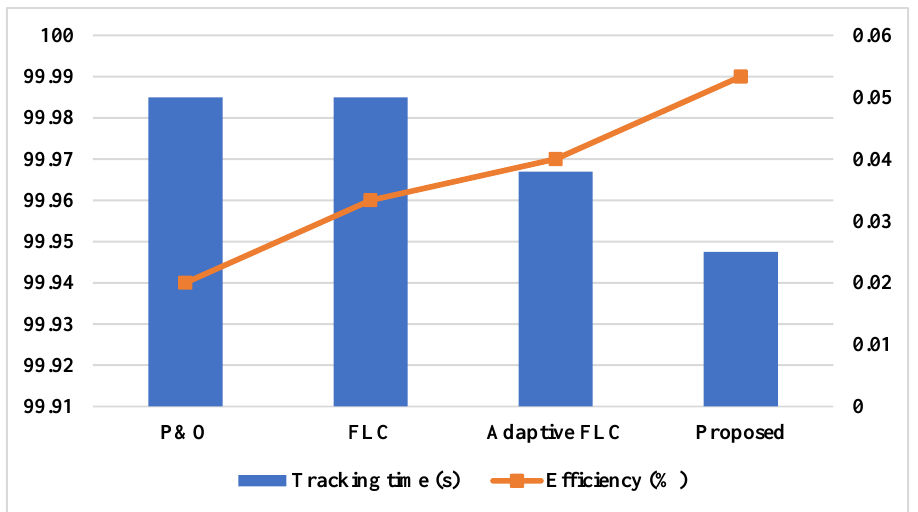
Figure 22. Comparative analysis based on tracking time and efficiency. Table 2. Qualitative comparative analysis.